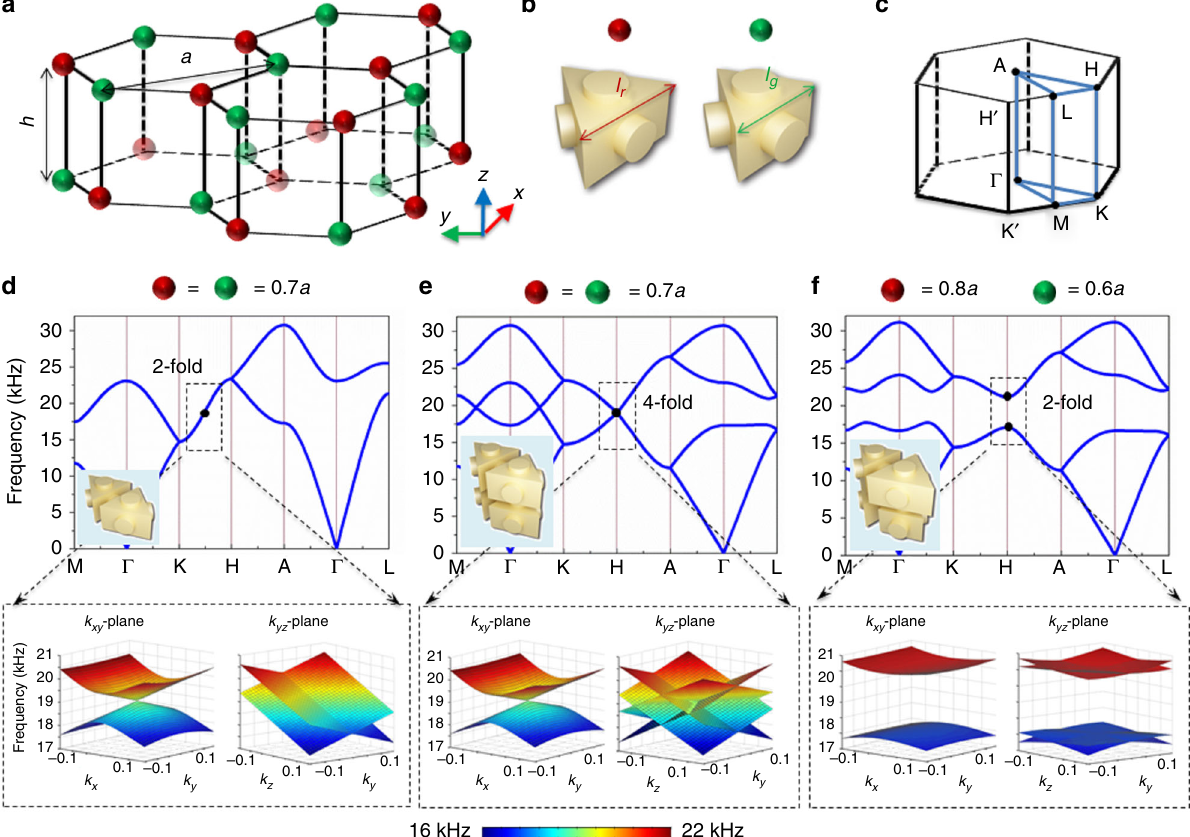
Fig. 1 Band structure evolution. a Schematic of the crystal structure formed by stacked double-layer honeycomb lattices. Red and green colours represent two types of atoms. b The acoustic atom is constructed using a triangular prism cavity with tubes. Different atoms have different side lengths. c The schematic for one-half of the fi rst Brillouin zone. d The band structures with identical acoustic atoms l g = l r = 0.7 a (one-layer primary unit cell). e The case of a double-sized unit cell. f The band structures with two different acoustic atoms ( l g = 0.6 a and l r = 0.8 a ) possessing glide symmetry. Insets show schematics for the primary unit cells. The lower panels show the bulk bands projected onto k xy and k yz planes near the degenerate point (black